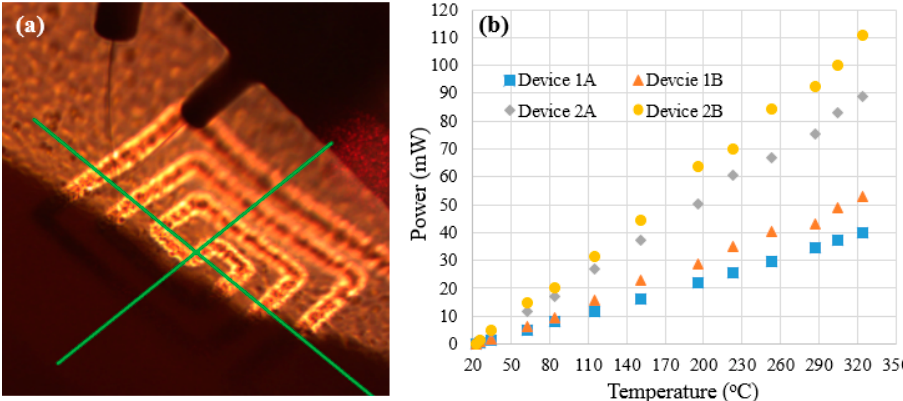
Figure 4. ( a ) Thermal scanning for temperature measurement, ( b ) Power cons μ mption against temperature.